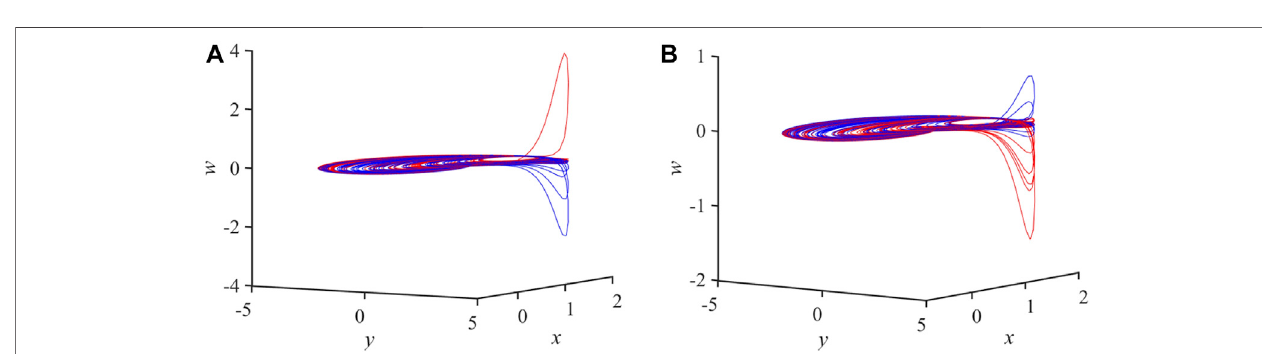
FIGURE 8 | The phase diagram of coexistence attractor, (A) initial values are (1, − 3, − 0.4, 7) and ( − 0.1, 0.4, − 0.1,7), (B) initial values are ( − 2, 3.6, − 0.1, 7) and (1, − 3, − 0.1, 7).